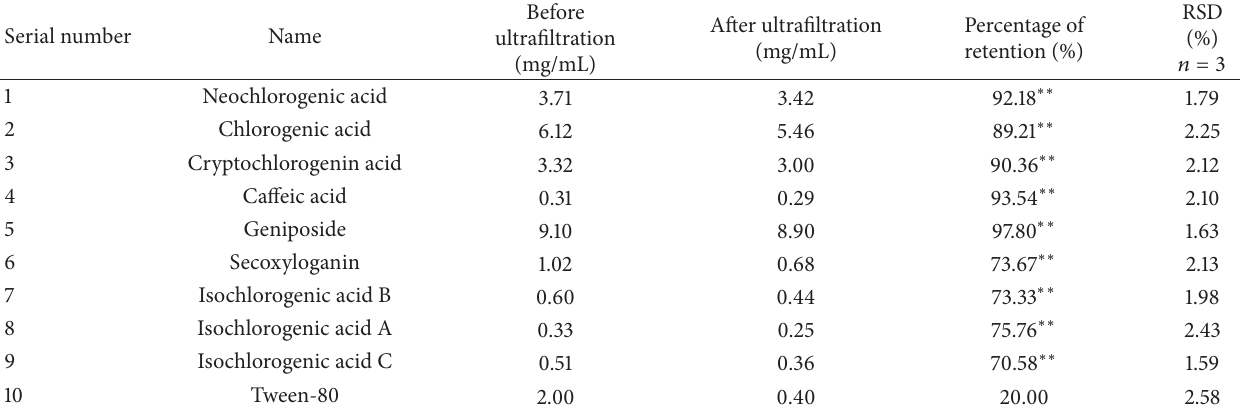
Values are expressed as mean ± SD; 𝑛 = 3 in each group. ∗∗ 𝑃 < 0.01 versus Tween-80 group.